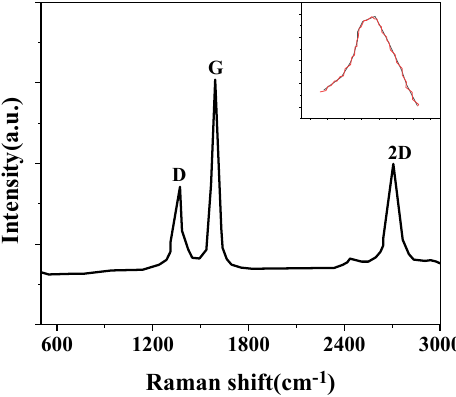
Figure 5. Raman spectrum of GO in N-doped GO composites.